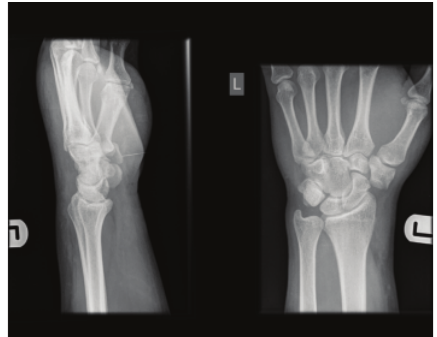
Figure 3: Radiographs at 6 weeks.